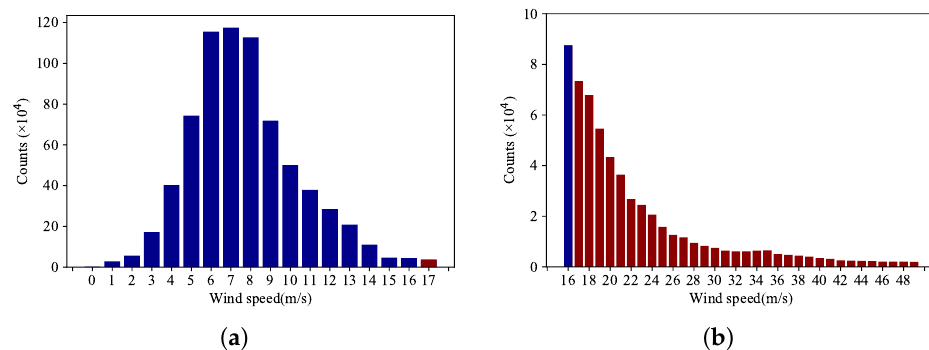
Figure 4. The blue histogram indicates that the wind speed is lower than 17 m/s, and the red histogram indicates that the wind speed is higher than 17 m/s. The ordinate ratios of ( a , b ) are different, and the number of wind fields with a speed higher than 17 m/s is obviously